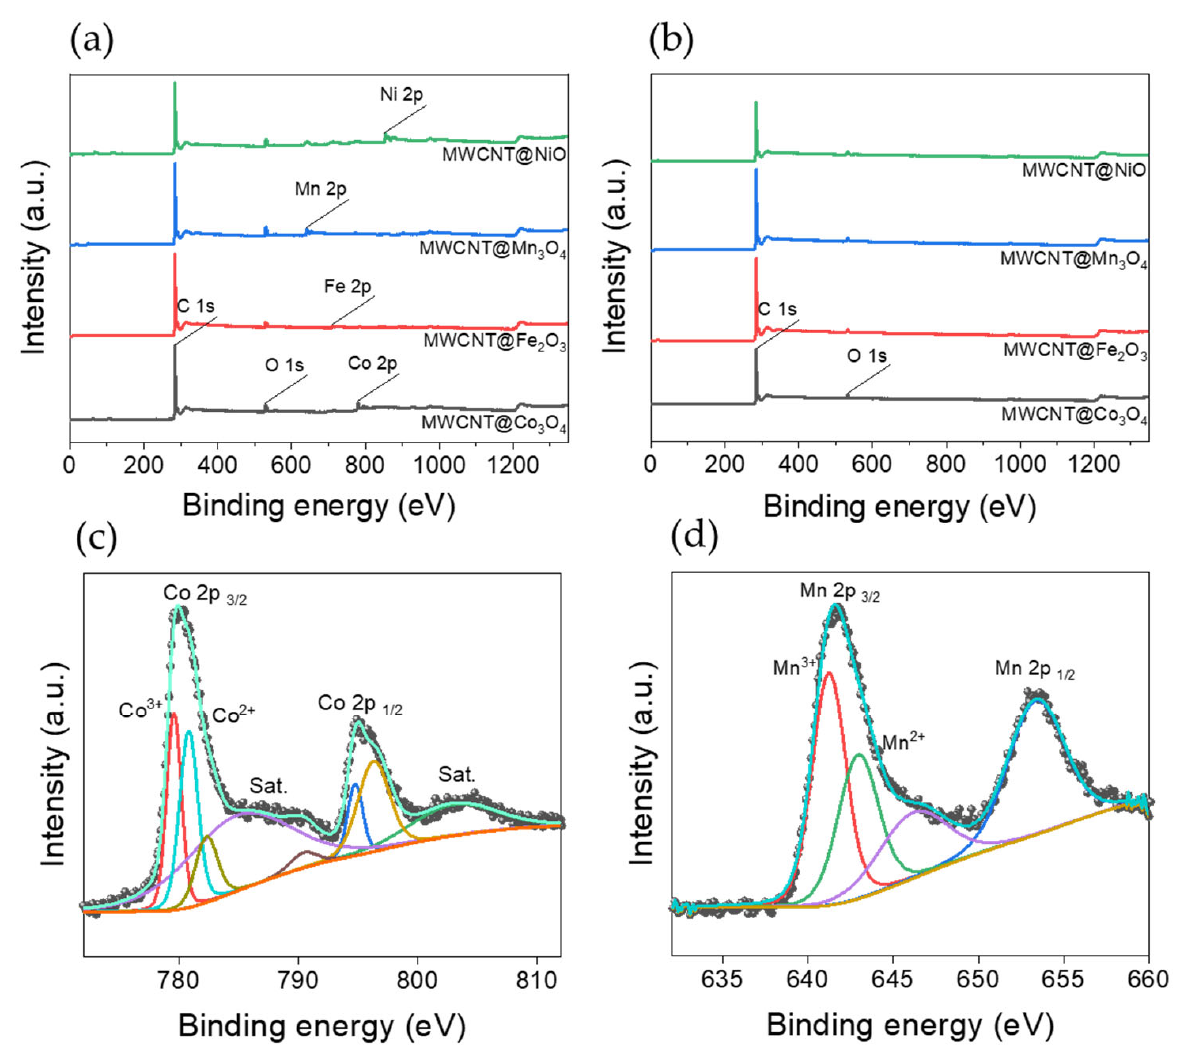
Figure 6. XPS survey spectra of ( a ) MWCNT@metal oxide NP composites, ( b ) multi-vacancy-defect MWCNTs and deconvoluted high-resolution XPS spectra of ( c ) Co 2p of MWCNT@Co 3 O 4 , ( d ) Mn 2p of MWCNT@Mn 3 O 4 .